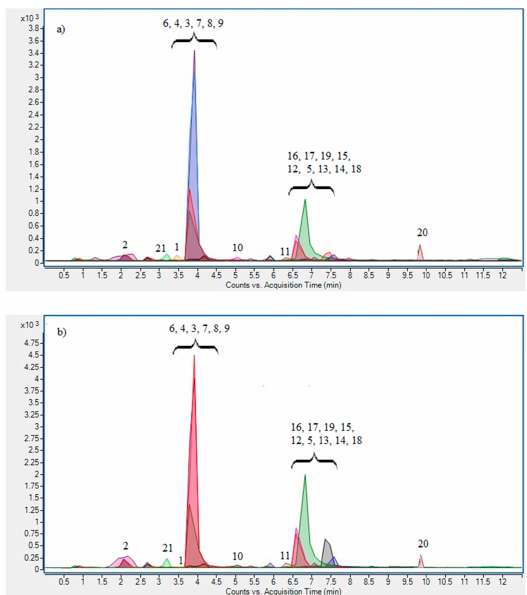
Figure 1. UPLC/ESI-MS 2 chromatogram in MRM acquisition from fennel seed extracts obtained un- der optimized MAE conditions ( a ), and CE ( b ): (1) p -hydroxybenzoic acid-O-glucoside, (2) Rosma- rinic acid, (3) Neochlorogenic acid, (4) Chlorogenic acid, (5) Dicaffeoylquinic acid derivate, (6), Caffeoylquinic acid derivate 1, (7) Caffeoylquinic acid derivate 2, (8) Feruloylquinic acid derivate 1, (9) Feruloylquinic acid derivate 2, (10) p -coumaroylquinic acid derivate, (11) Rutin, (12) Kaempferol- 3-rutinoside, (13) Isorhamnetin hexoside 1, (14) Isorhamnetin hexoside 2, (15) Quercetin glucu- ronide, (16) Quercetin hexoside, (17) Quercetin-3-glucoside, (18) Kaempferol glucuronide, (19) Kaempferol hexoside, (20) Apigenin glucuronide, (21) Esculetin hexoside.